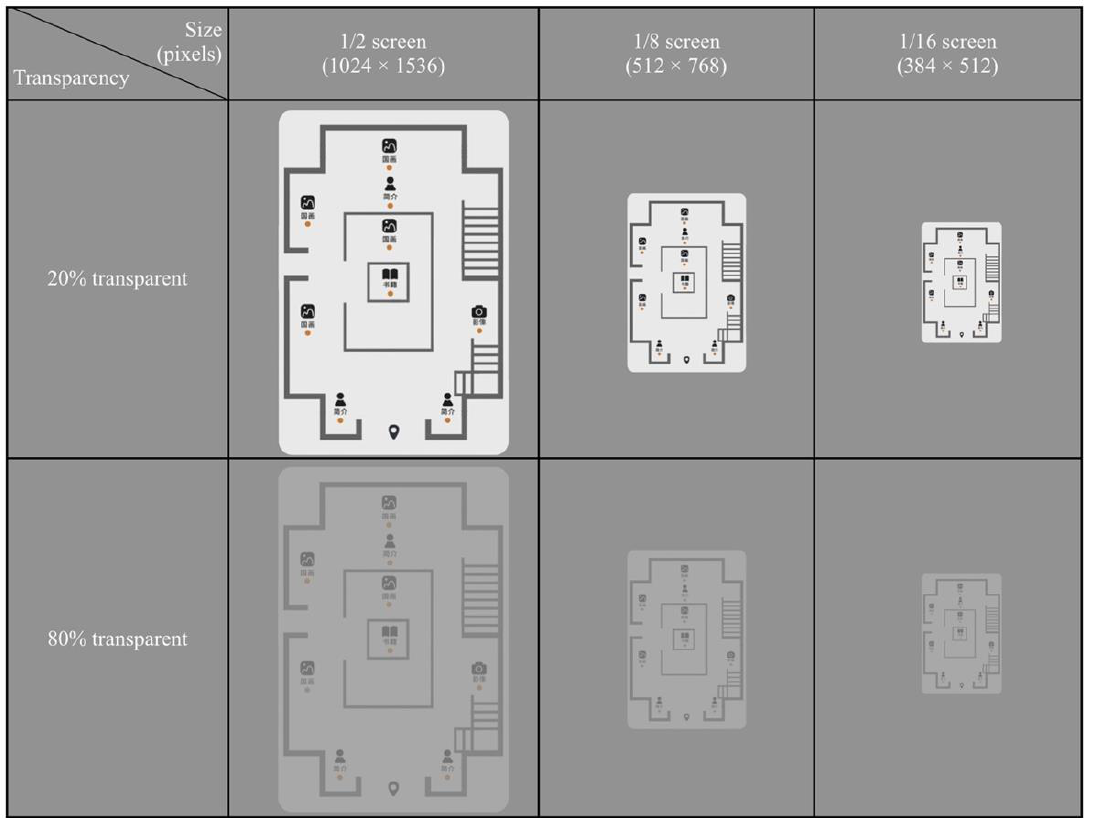
Figure 2. Examples of the virtual museum interfaces: ( a ) the 1/2 screen-size 20% transparent overview map of the ground floor; ( b ) the 1/2 screen-size 80% transparent overview map of the second floor.